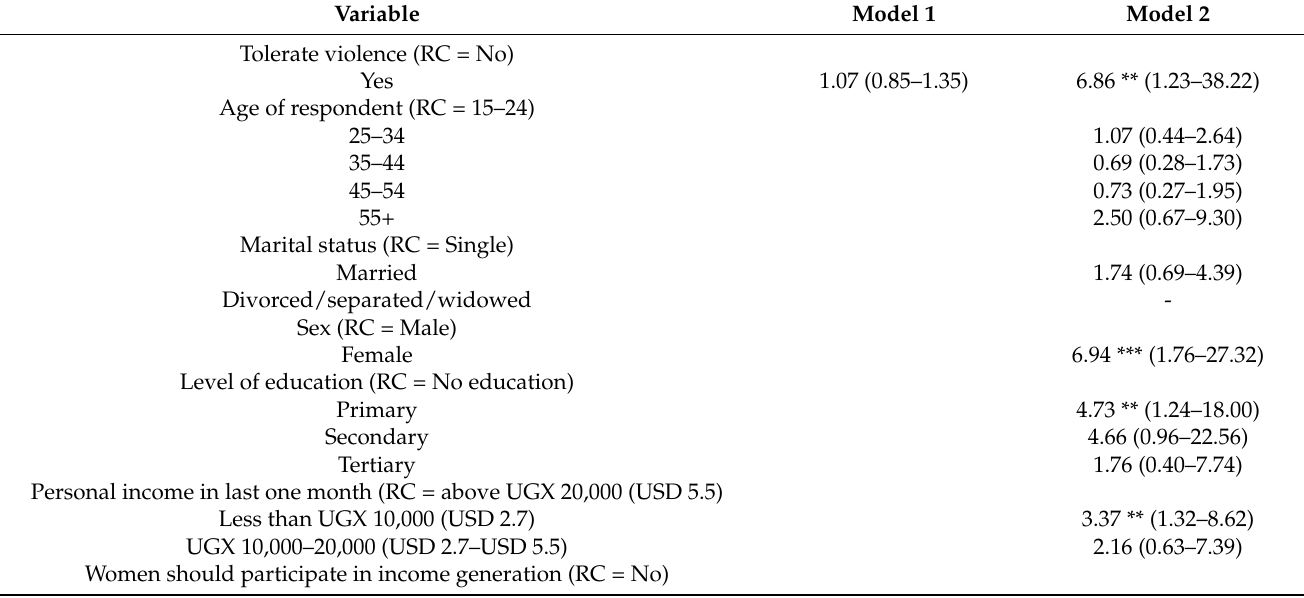
Table 3. Factors associated with the risk of experiencing psychosocial